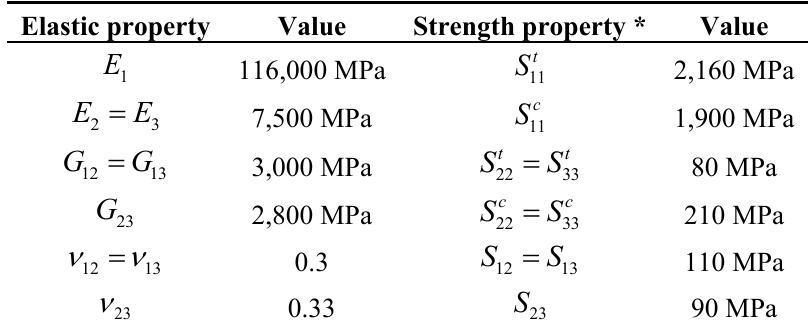
Table 5. Material properties of the specimen (each